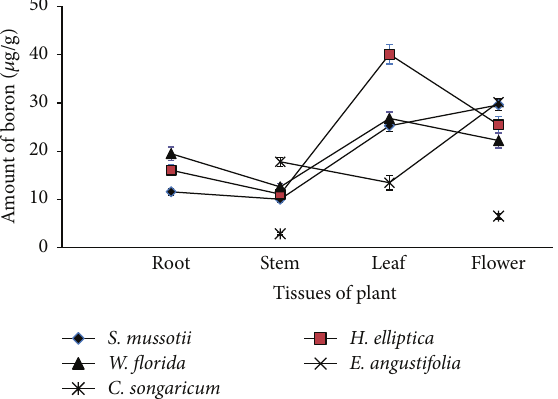
Figure 3: Variation of 𝛿 11 B in the plant